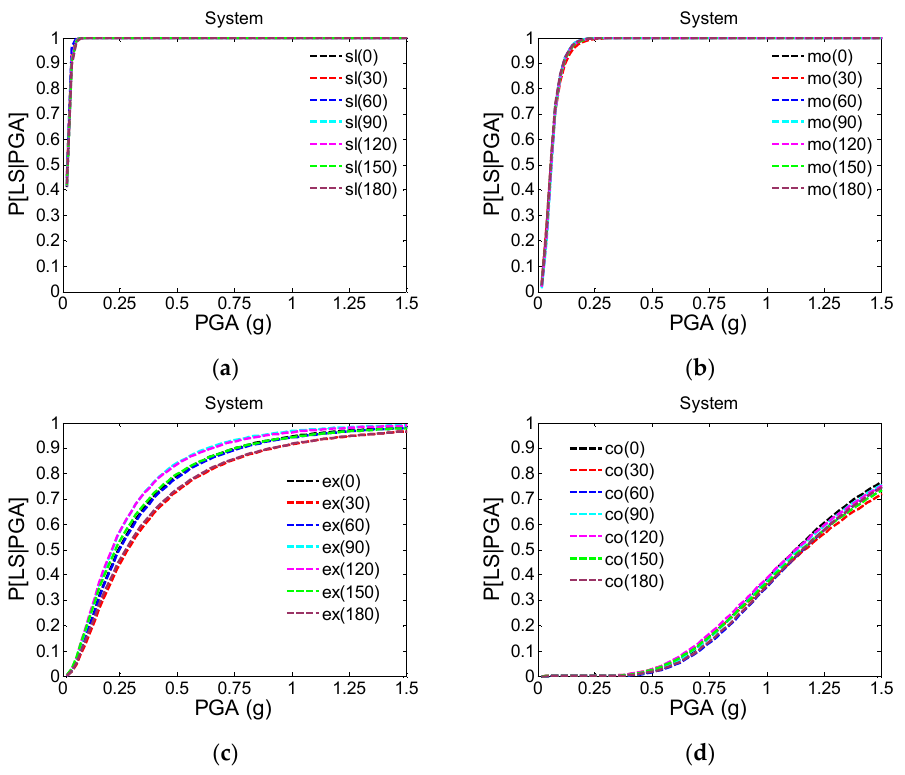
Figure 13. Seismic fragility curves of the bridge system subjected to different excitation angles in the ( a ) slight; ( b ) moderate; ( c ) extensive; and ( d ) complete limit states.